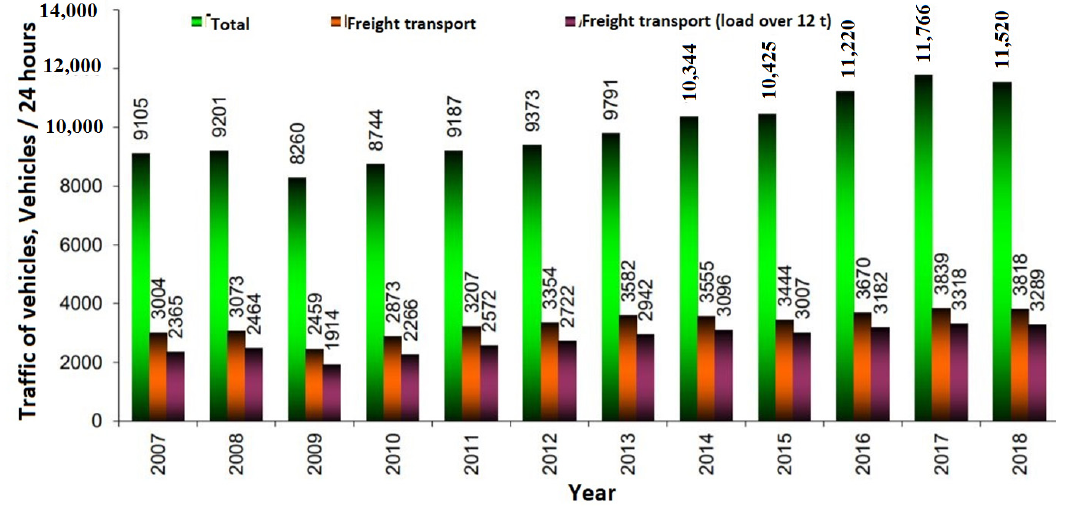
Figure 2. Change of the average annual daily traffic intensity in Via Baltica transport corridor.